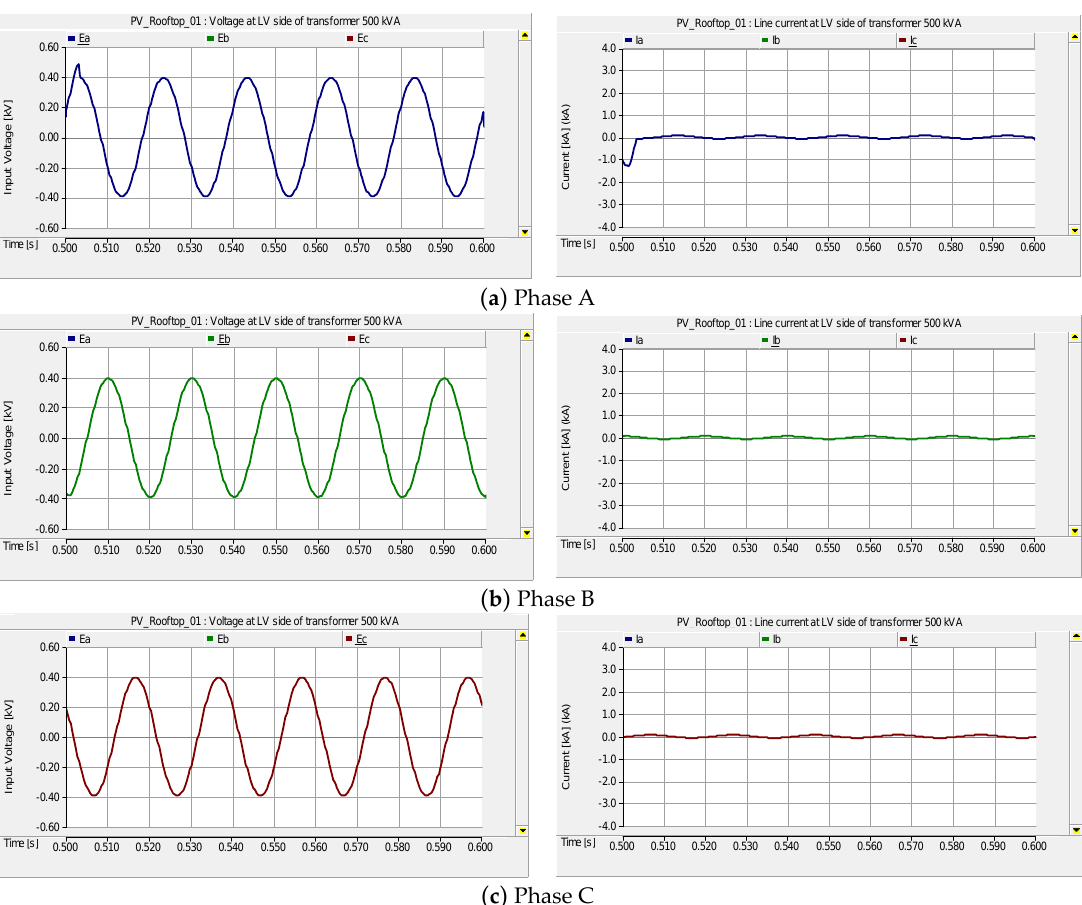
Figure 21. The voltage and current at the LV side (0.4 kV) transformer 500 kVA when the BRKA open circuit is at 0.5 s.